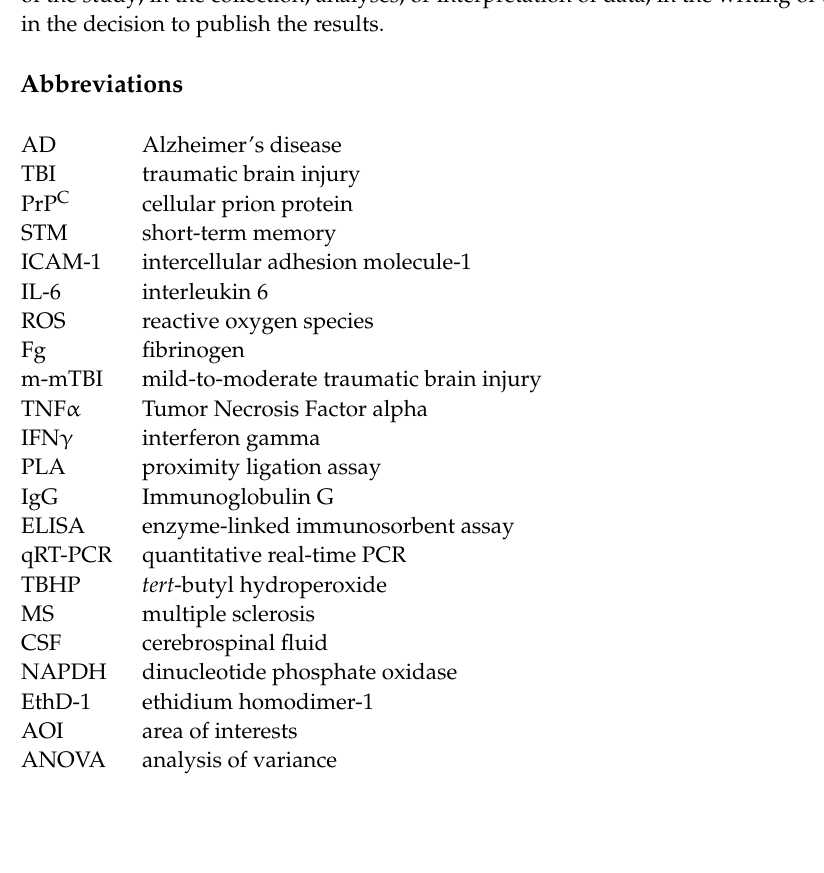
(PLA), Figure S3: Homogeneity of neuronal cell